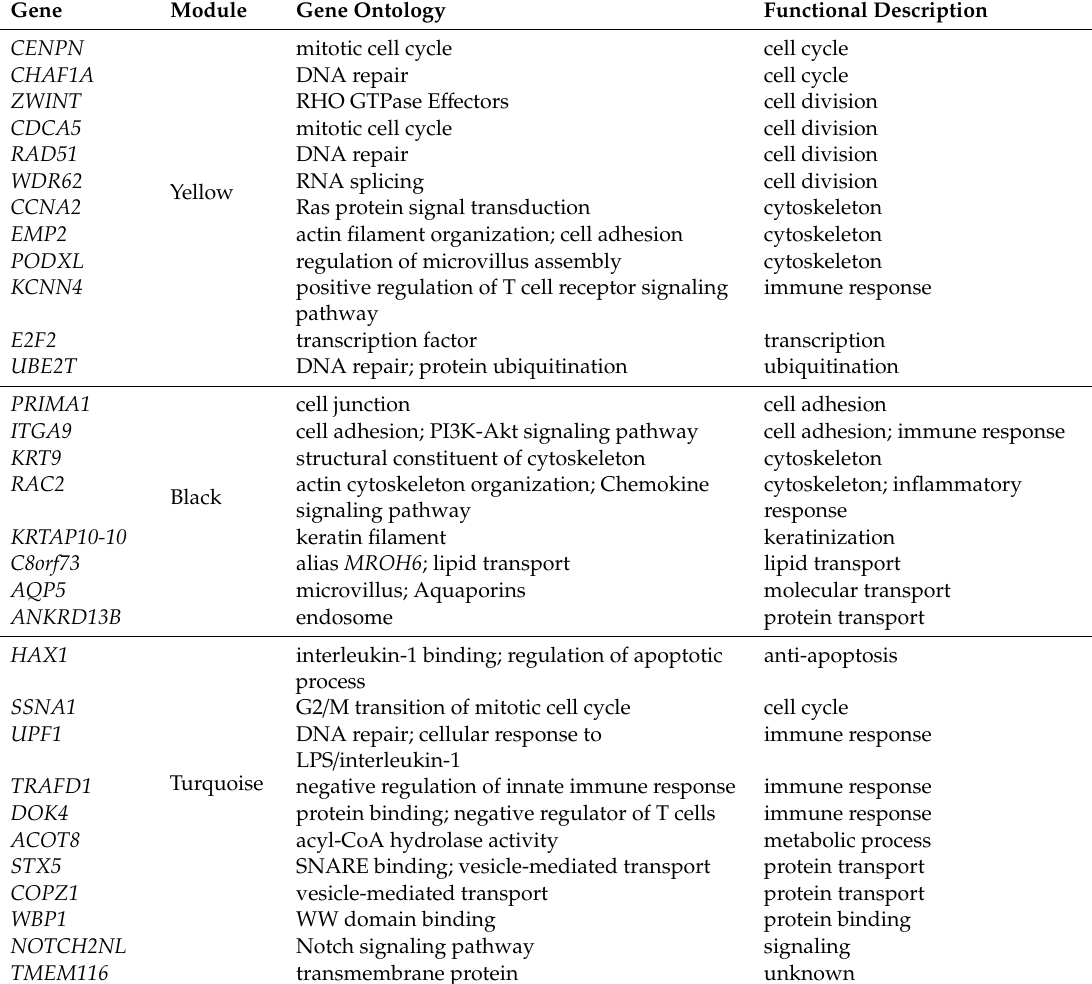
Table 2. Hubs in Caco-2 / Ec472